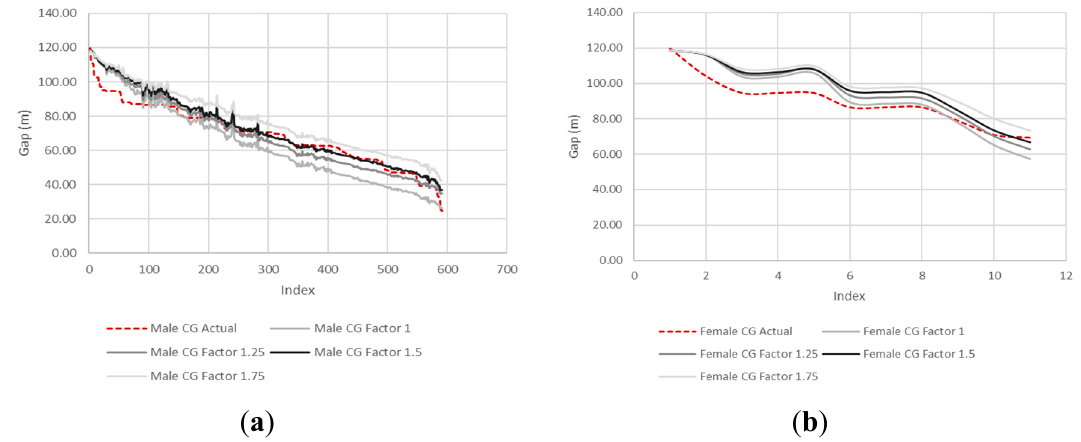
Figure 5. Comparison between actual data and simulation results per gender. ( a ) Male; ( b ) female.